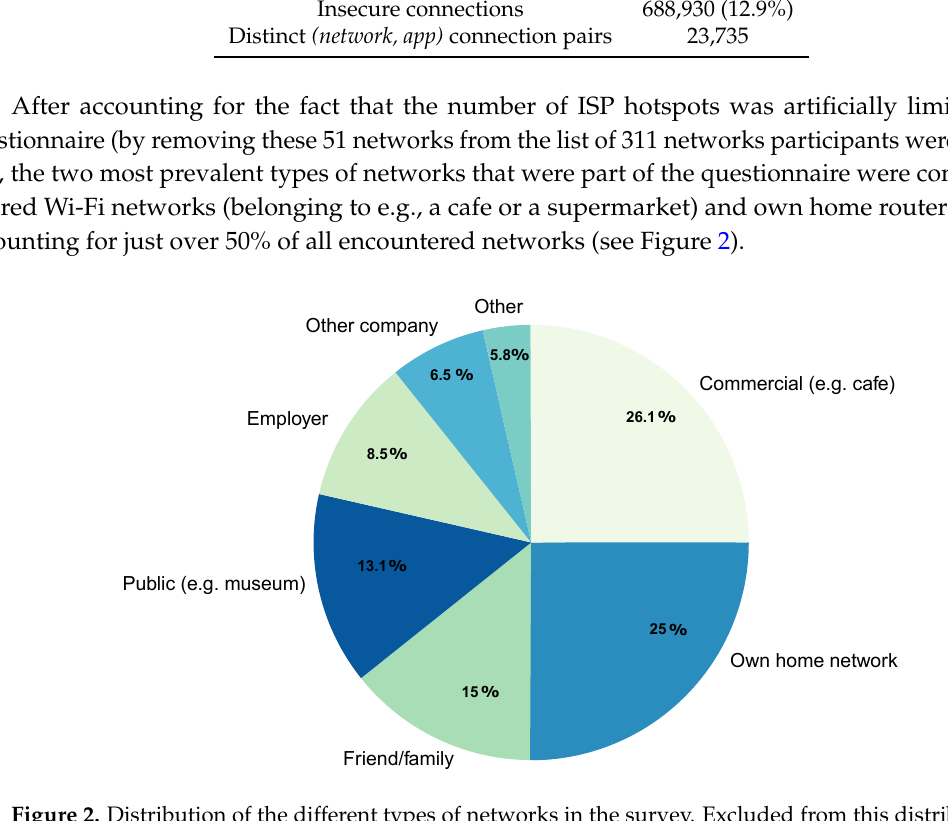
Figure 2. Distribution of the different types of networks in the survey. Excluded from this distribution are 51 networks having the “ISP hotspot” type, as these were purposefully limited to at most one (see Section 3.2 for more information). The two most prevalent types of networks that were part of the questionnaire were commercially offered networks and own home routers, together accounting for just over 50% of all encountered